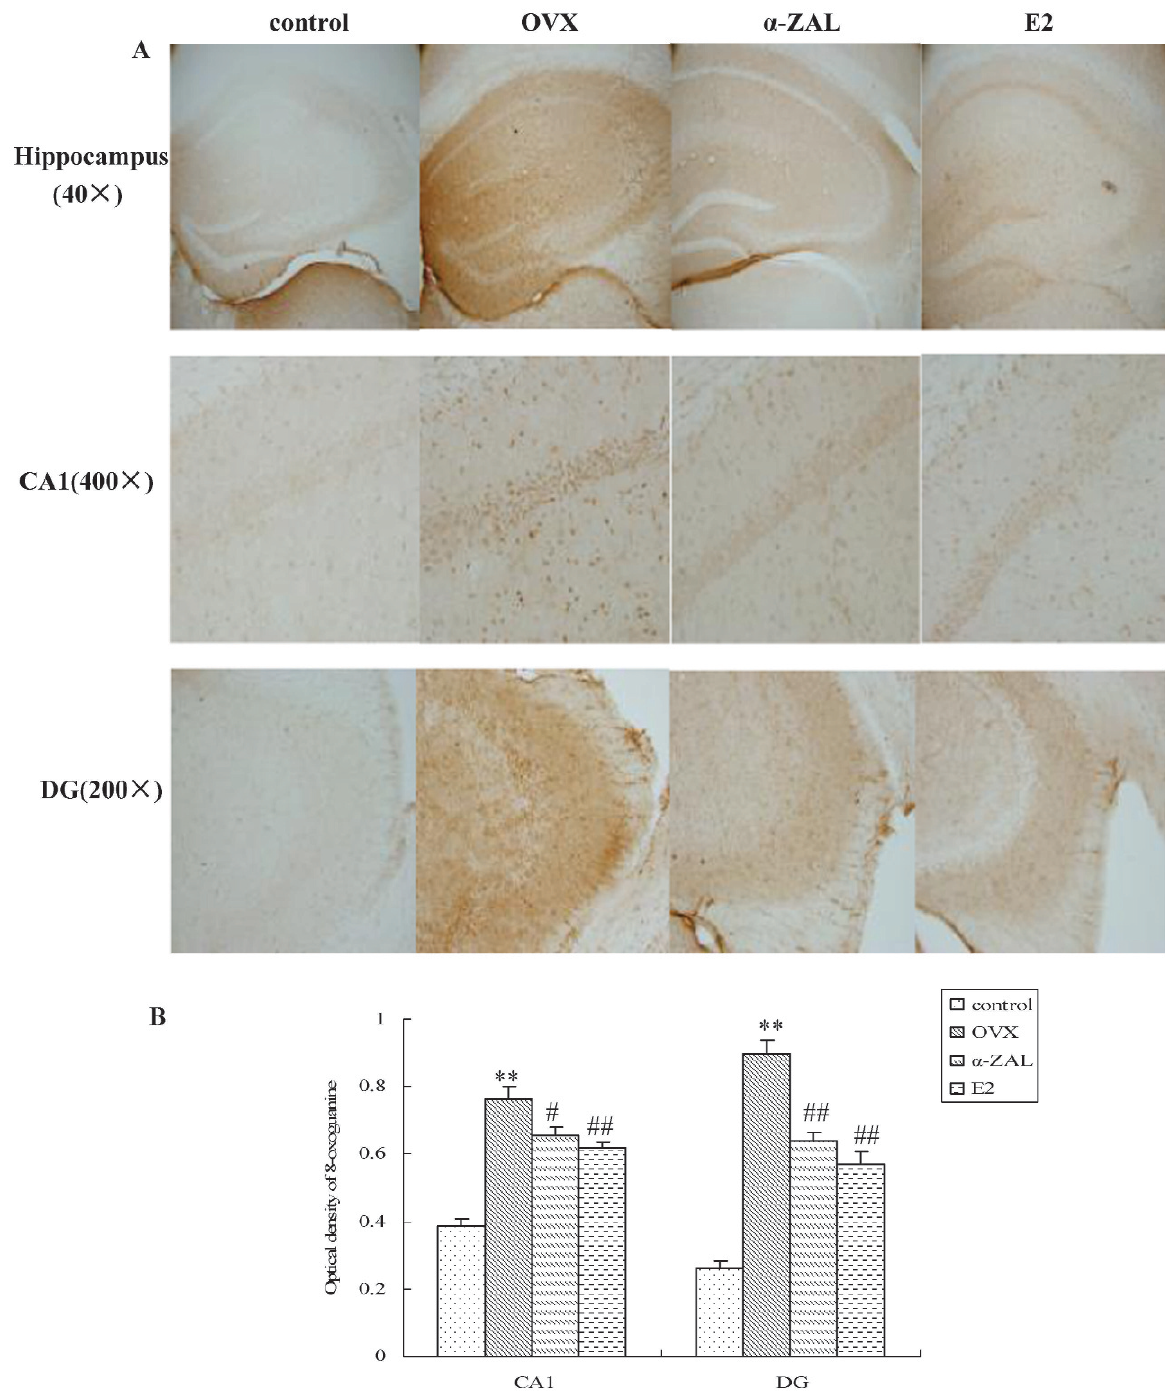
Figure 3 - The effect of E2 and a -ZAL treatment on the levels of 8-oxoguanine in the hippocampi of mice. A. The immunohistochemical analyses of free-floating sections (25 m m in thickness). The first row shows a lower magnification of the hippocampus (40 6 ), whereas the magnified views of the CA1 (400 6 ) and DG (200 6 ) subregions are shown in the middle and last rows, respectively. B. Quantification of 8-oxoguanine immunolabeling in the CA1 and DG regions of the hippocampus. n=4 in each group. The results represent at least three independent experiments in each animal. ** p , 0.01 vs. control group; # p , 0.05 and ## p , 0.01 vs. OVX